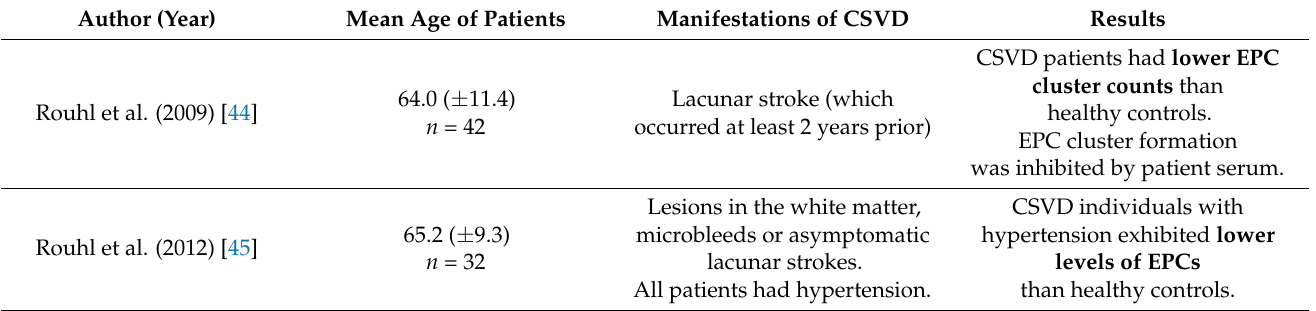
Table 3. A summary of studies on number of circulating EPCs in patients with cerebral small vessel